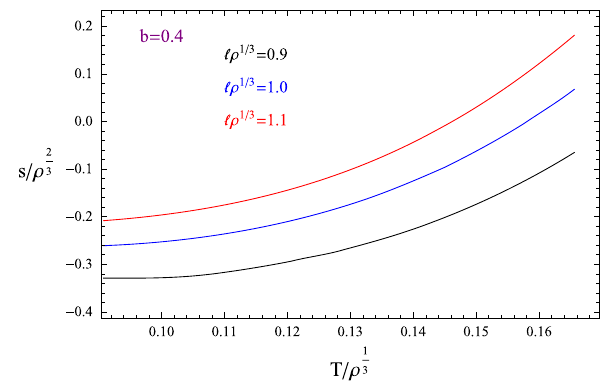
Fig. 3 The entanglement entropy of the operator (cid:2) O + (cid:3) with respect to the temperature T for various widths (cid:14) as b = 0 . 4. The red line is √ ρ = 1 . 1, the blue line is for (cid:14) for (cid:14) √ (cid:14) ρ = 0 . 9